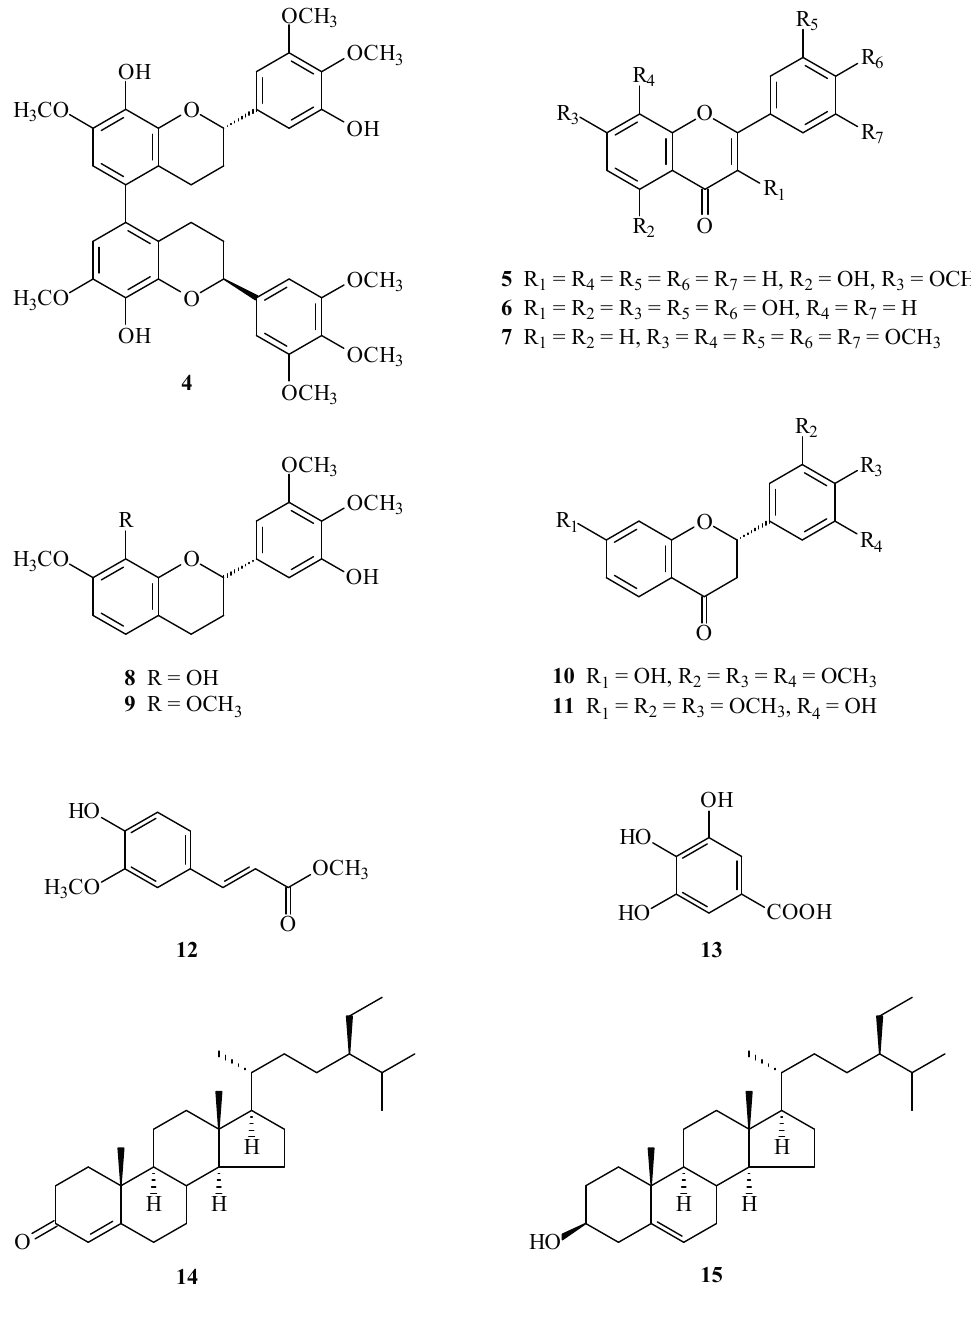
Figure 2. The chemical structures of known compounds 4 – 15 isolated from M. calabura